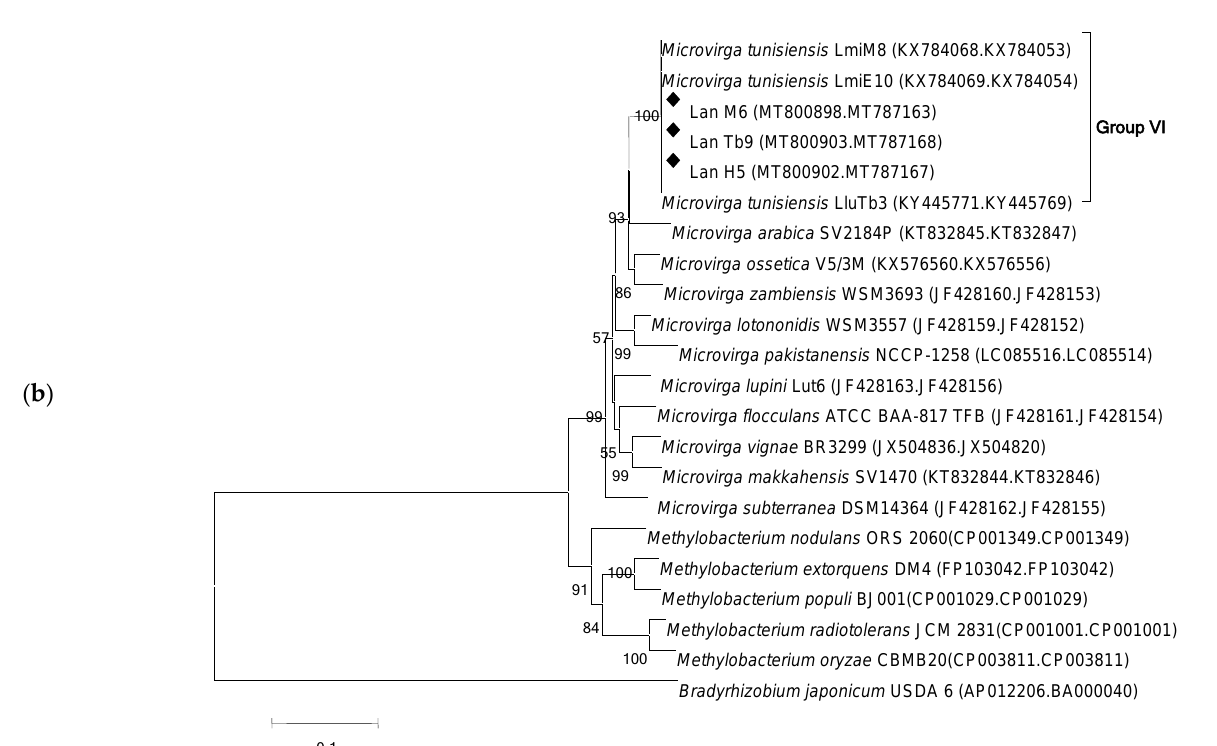
Figure 2. Neighbor-joining phylogenetic trees of Tunisian L. angustifolius (Lan) microsymbionts and reference strains based on concatenated gene sequences. ( a ) Phylogeny of the Bradyrhizobium isolates based on recA and glnII sequences. ( b ) Phylogeny of the Microvirga isolates based on gyrB and dnaK sequences. Filled diamonds: Tunisian Lan isolates obtained in this work. Bootstrap values calculated for 1000 replications and those greater than 50% are indicated at the internodes. GenBank accession numbers are shown in brackets .